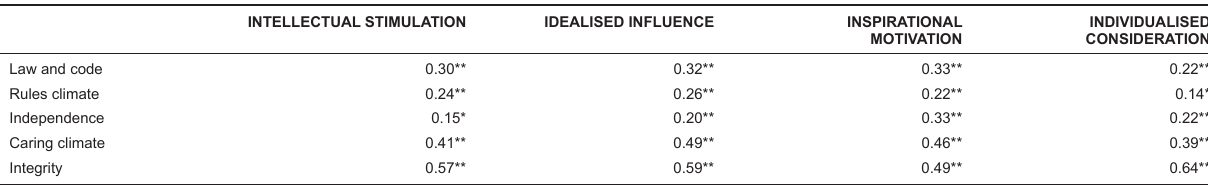
TABLE 2 Pearson product-moment correlation between integrity, transformational leadership and an ethical climate (n =